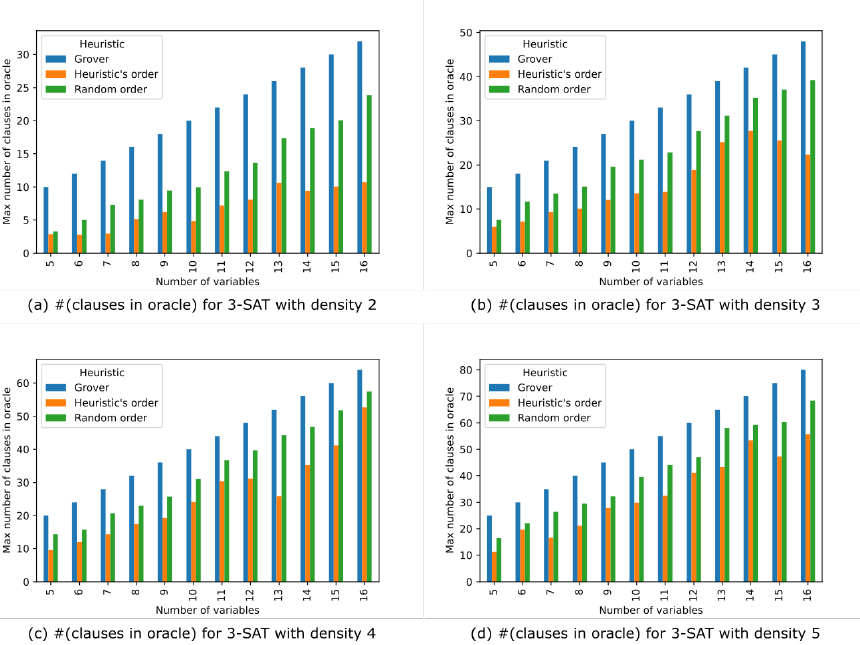
Figure 5. Comparisons of number of clauses in oracle according to densities of 3-SAT